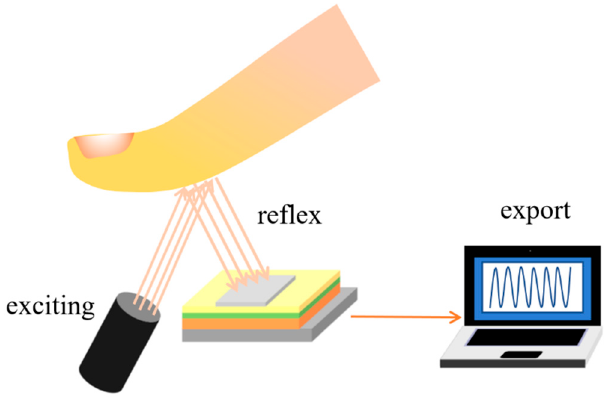
Figure 8. Schematic diagram of the photoelectric heart pulse sensor.